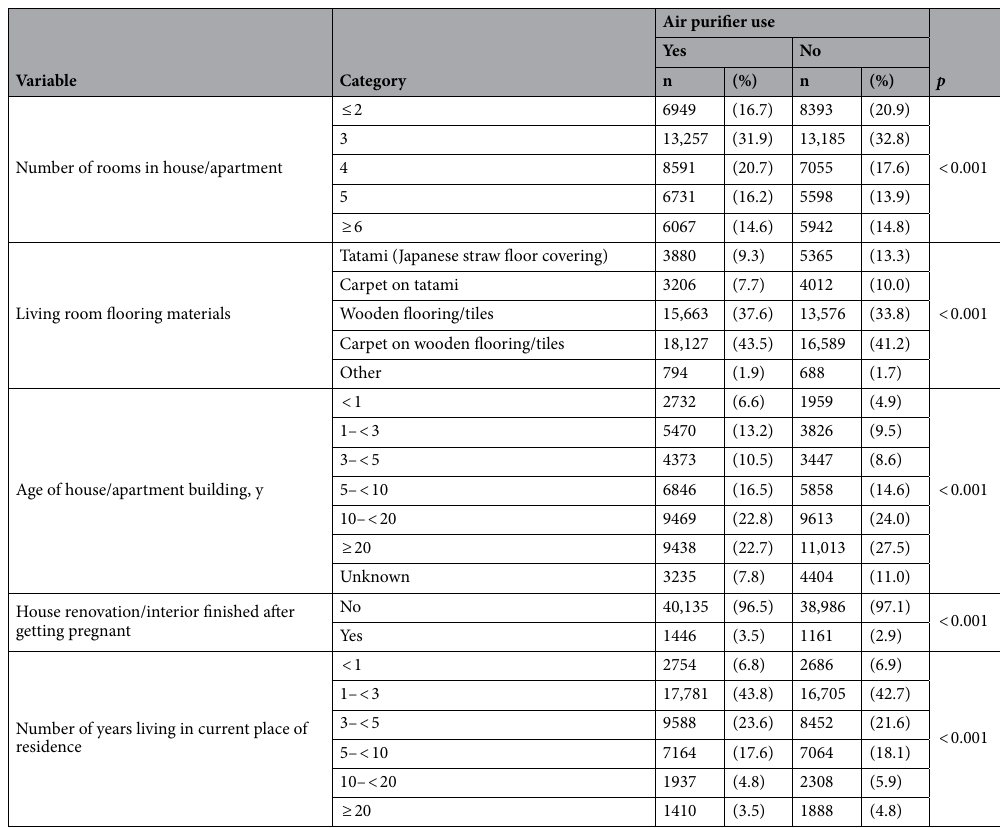
Table 1. Characteristics of the participants and dwelling environments.